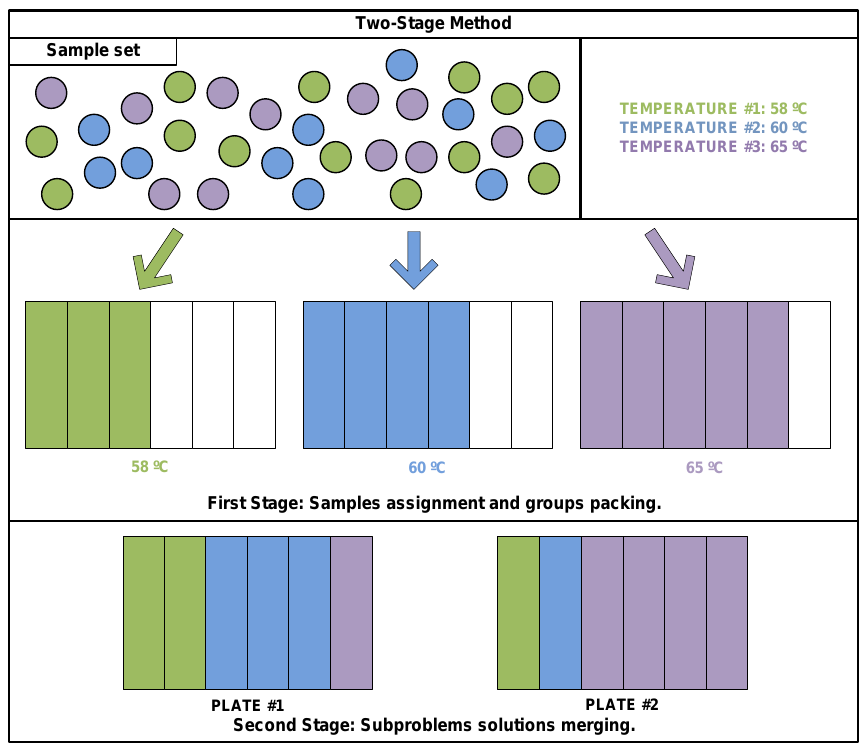
Figure 4. Two-stage method diagram.